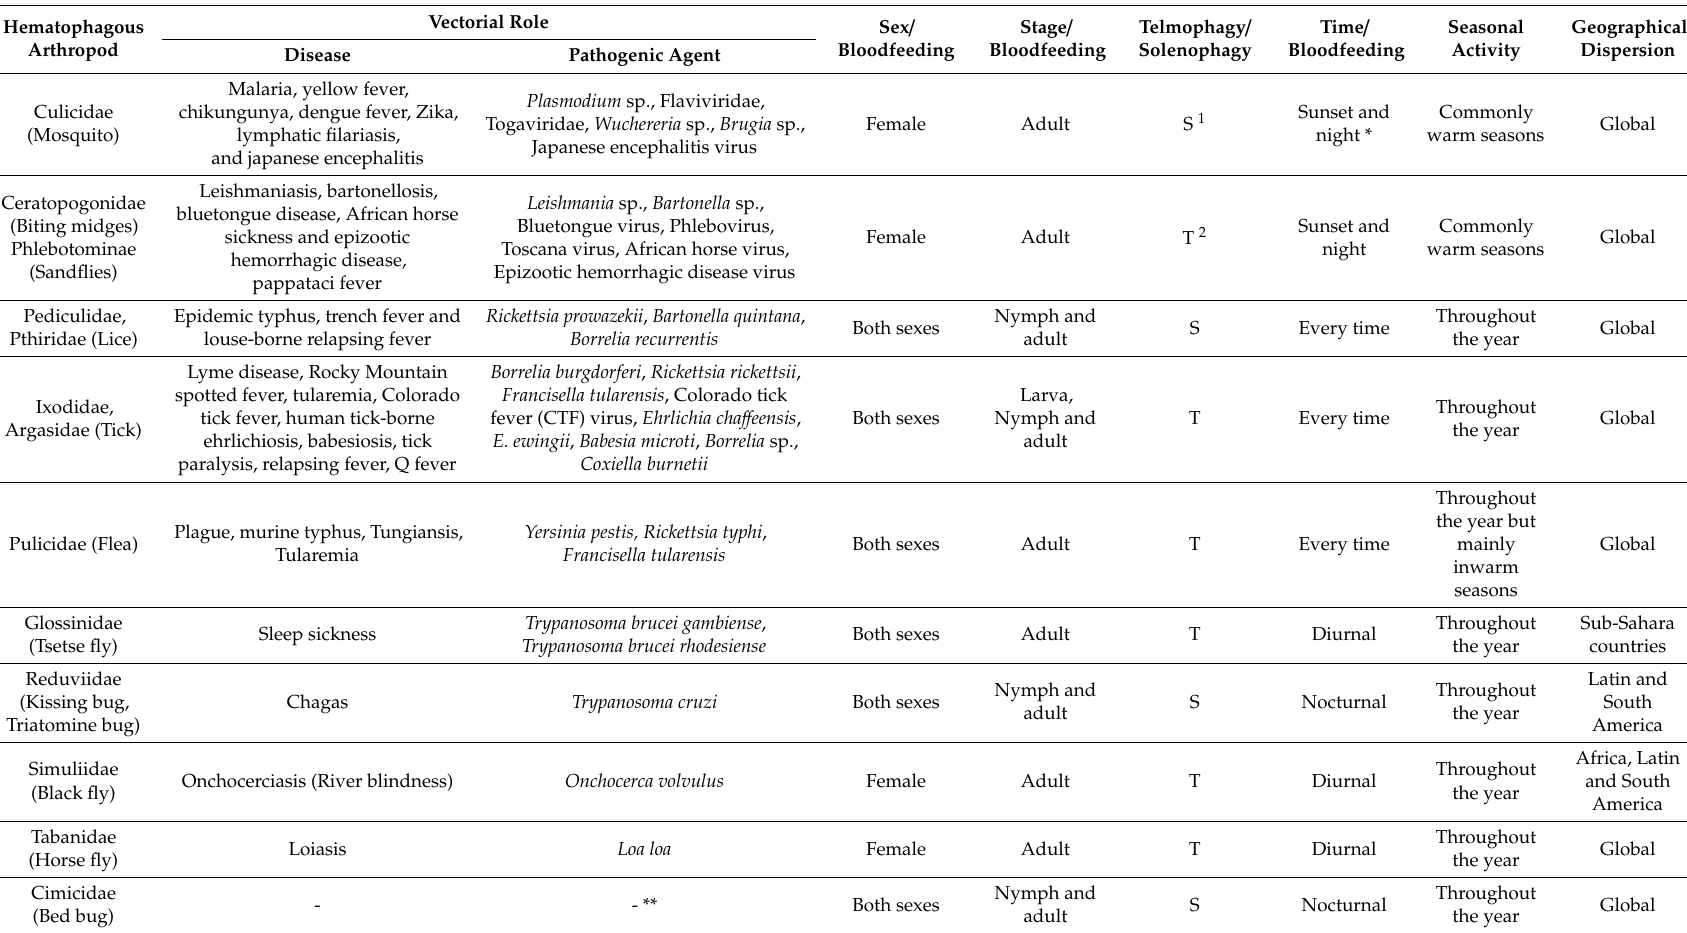
Table 1. Entomo-epidemiological criteria of hematophagous arthropods